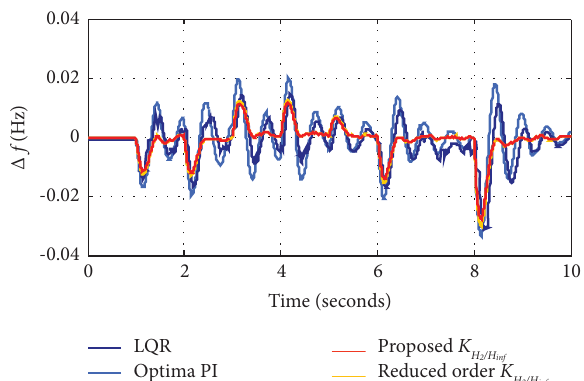
Figure 16: Power fuctuations in the wind, PV, and loads as main disturbances in scenario III.